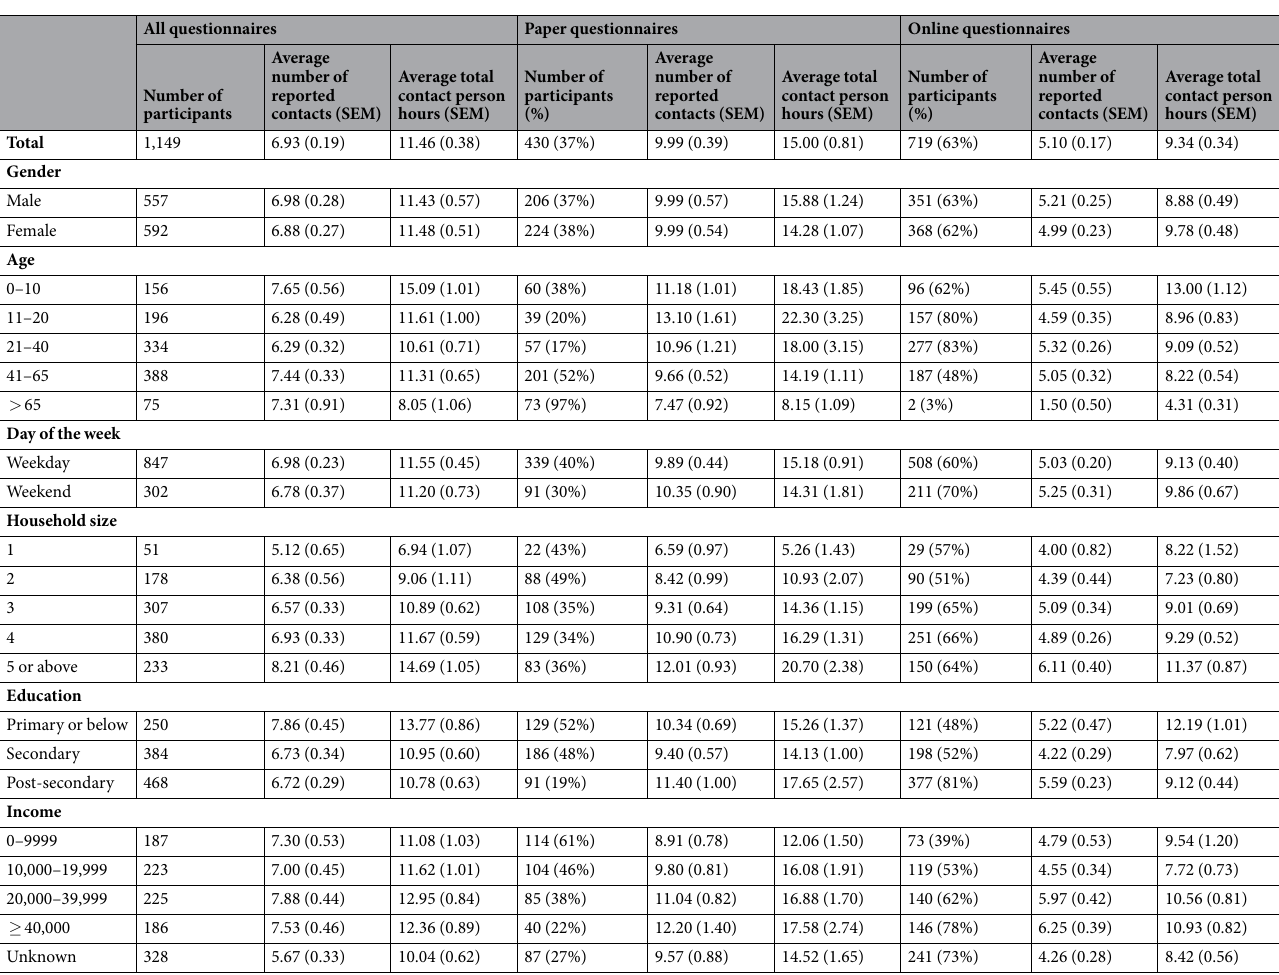
Table 1. Mean number of reported contacts and mean total contact person hours by participant gender, age, day of the week, household size, education, income level and mode of